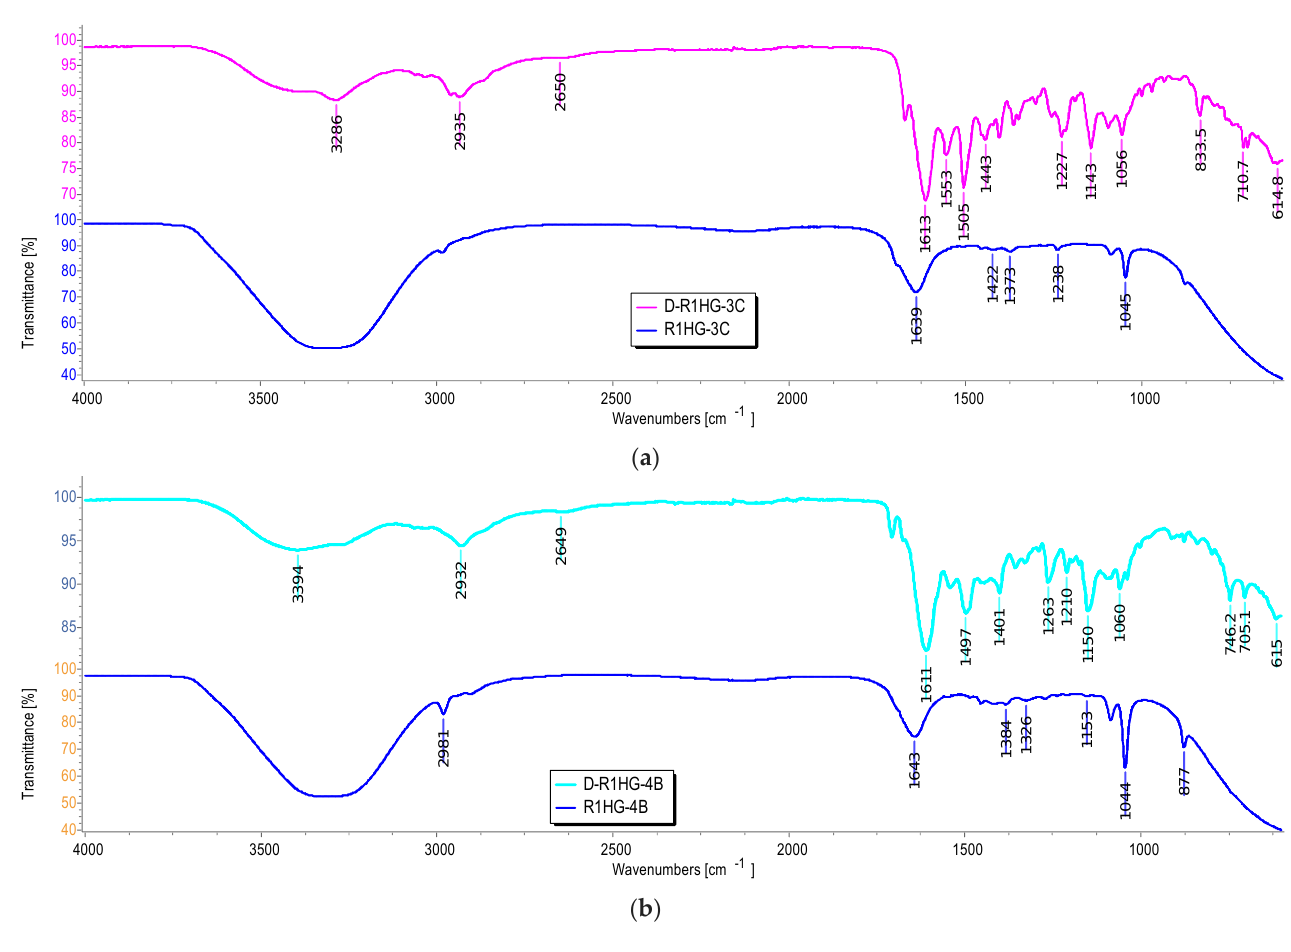
the presence of all three main ingredients in the structure of R1. No significative band mer M1.